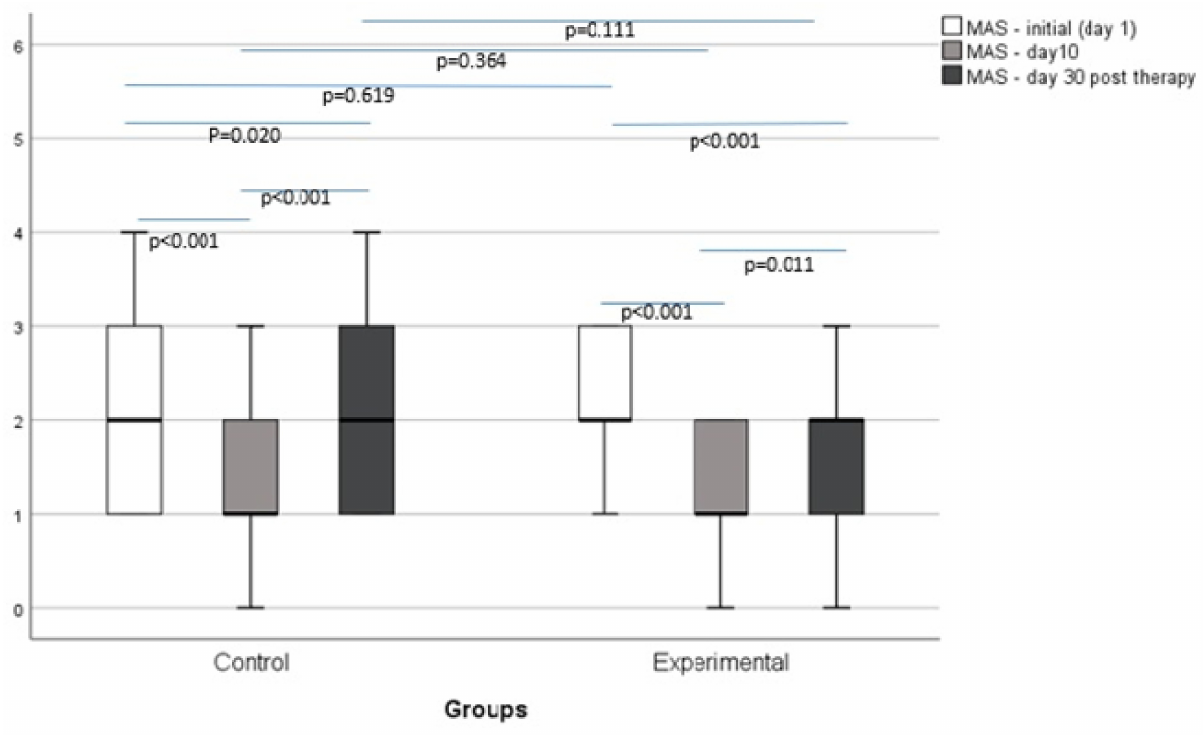
Figure 1. MAS mean comparison.